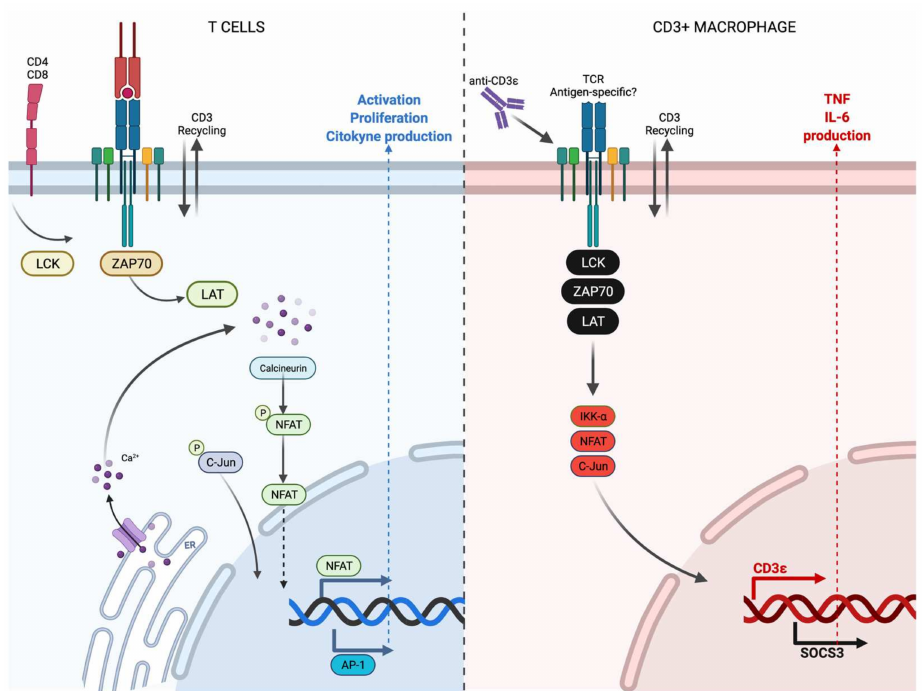
Figure 6. Current knowledge of the CD3 downstream signaling in T cells and macrophages. T cells express the CD3/TCR complex, and these cells are activated after the TCR recognizes a specific antigen. Lck, ZAP70 and LAT are recruited to stimulate the nuclear factors NFAT and AP-1, to finally favor functions such as activation, proliferation, and cytokine production ( left ). CD3+ macrophages also express CD3, and some of them are TCR+. At present, it is still unclear if this TCR is antigen- specific, but these cells can be activated by anti-CD3 stimulus. Lck, ZAP70, LAT, IKK-a, NFAT and C-Jun play a role in activating the CD3+ macrophages and favor the delivery of pro-inflammatory cytokines such as TNF and IL-6 ( right ). The figure was created in